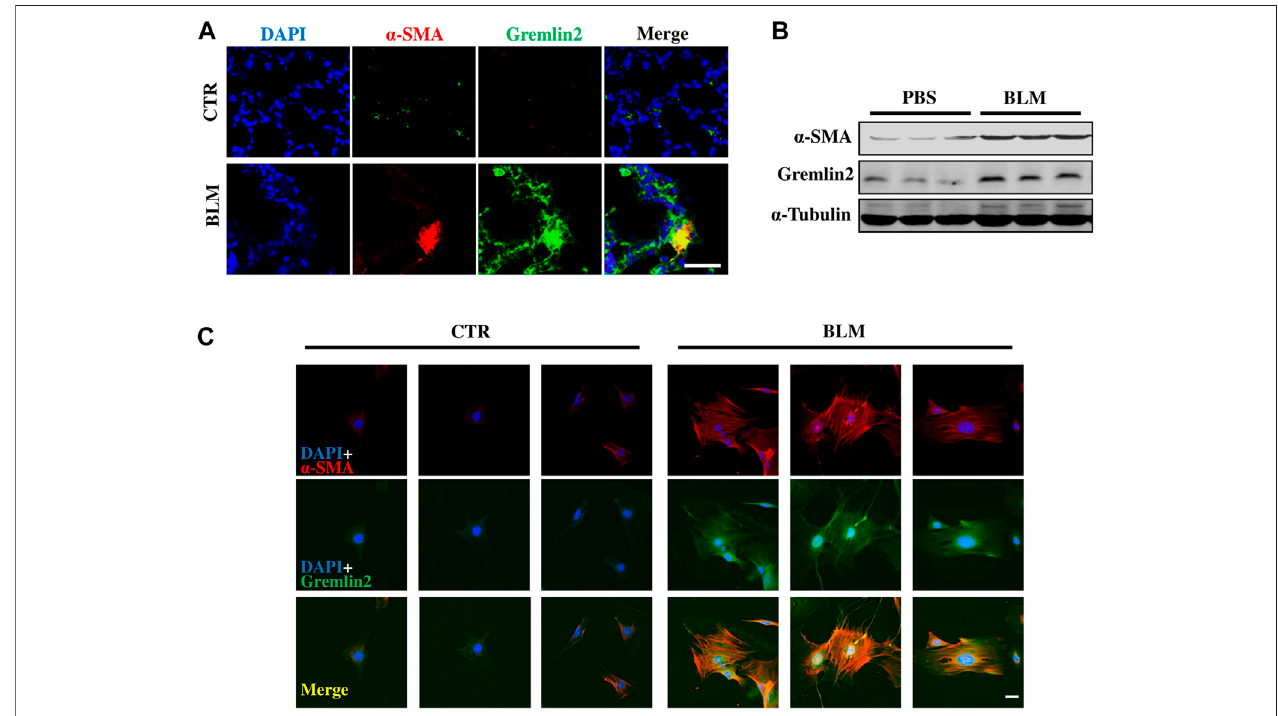
FIGURE 4 | Myo fi broblast expresses high level of Gremlin2 in bleomycin induced lung fi brosis model through co-localization (A) Immuno fl uorescence shows co- localization of fi broblast activation marker ( α -SMA) and Gremlin2 in lungs of bleomycin-induced fi brosis mice, Gremlin2 (Green), and α -SMA (Red), DAPI (Blue), Yellow (Merge), scale bar (cid:2) 10 μ m. (B) Fibroblasts were isolated from mice after PBS or bleomycin treatment on day 14, then western blotting was performed to detect the expression of Gremlin2, and α -SMA. Every group contained three mice. CTR n (cid:2) 3, BLM n (cid:2) 4. (C) Following the same operation method as (B) , then immuno fl uorescence was performed to detect the expression of Gremlin2 (Green), and α -SMA (Red). DAPI (Blue) indicated the nucleus. Scale bar (cid:2) 20 μ m. CTR n (cid:2) 3, BLM n (cid:2) 4. CTR, control with PBS-treated group; and BLM, bleomycin-treated group.